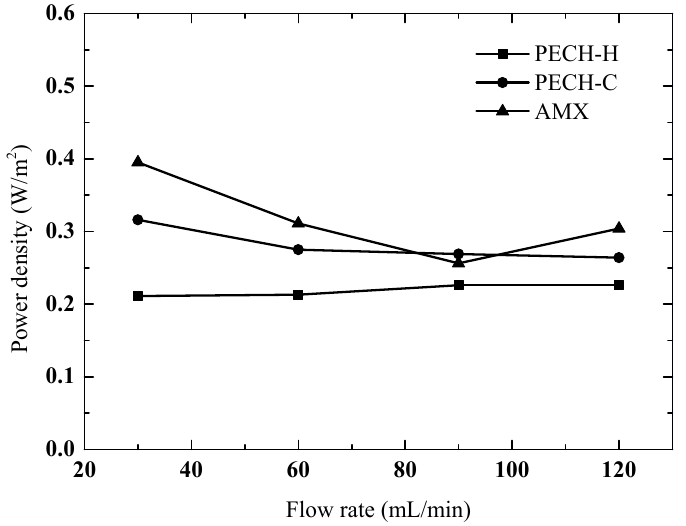
Figure 12. Benchmarking of RED performance of the two types of PECH AEMs with commercial Neosepta AMX membrane (CEM: Neosepta CMX).